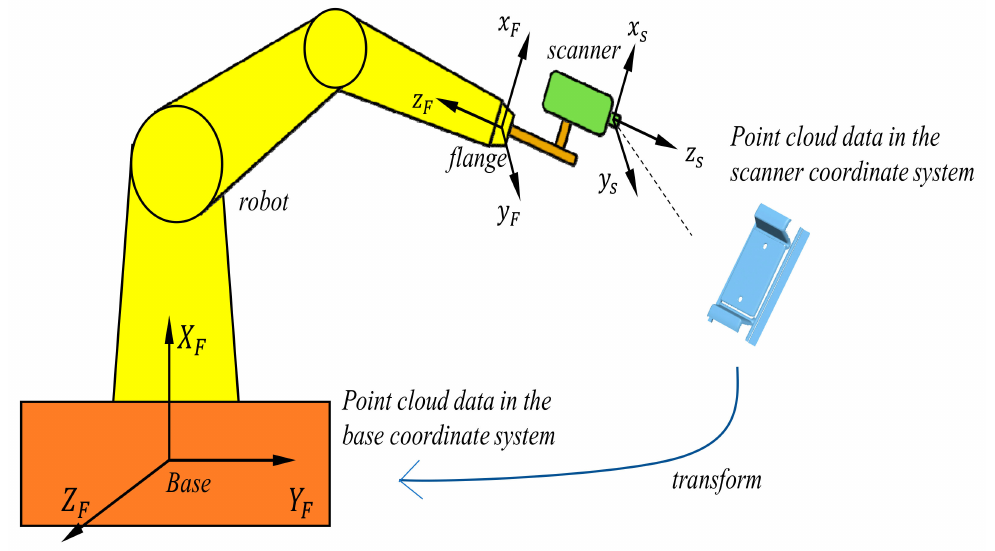
Figure 4. Schematic diagram of point cloud